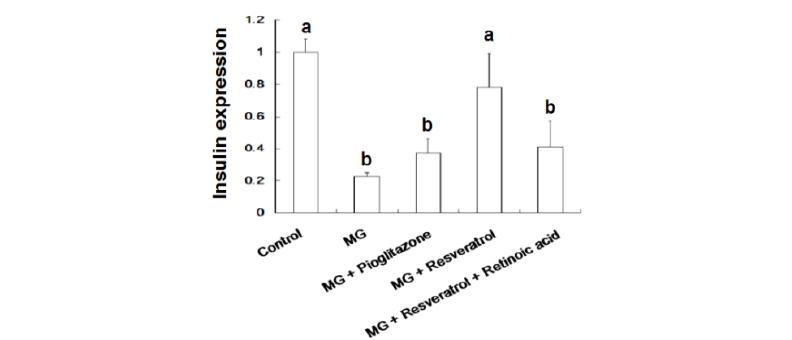
Figure 5. Immunohistochemical visualization of pancreatic insulin in methylglyoxal-treated mice treated with resveratrol ( n = 6). The bars represent the pancreatic cellular insulin content of different treatment groups. (a,b) indicate a statistically-significant difference at p < 0.05.